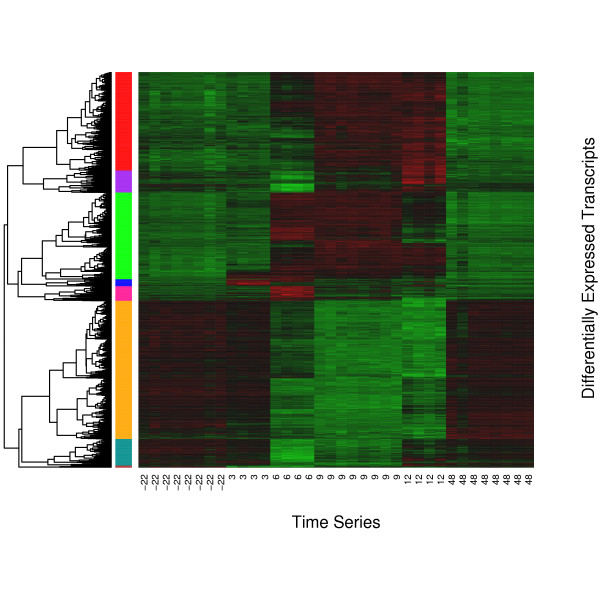
Heatmap of differentially expressed transcript sets. 4610 transcripts were differentially expressed (adjusted P < 0.01). Normalized intensity values of transcripts (rows) are ordered using Centered Pearson correlation and hierarchical clustering. The dendrogram show the similarity (distance) of expression profile of transcripts and is divided into 8 sub-trees as indicated in the color bar. Arrays (columns) are grouped according to the sampling time which varies from -22 to 48 hours subject to LPS infusion. Red and green colors reflect the high and low intensities respectively.